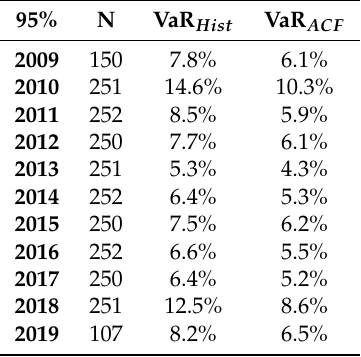
Table 2. Percentages of